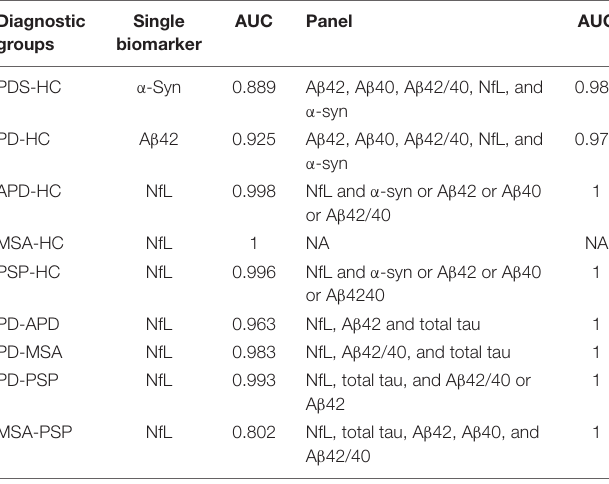
TABLE 5 | The best single biomarker and panel in comparing different parkinsonian syndromes with each other and